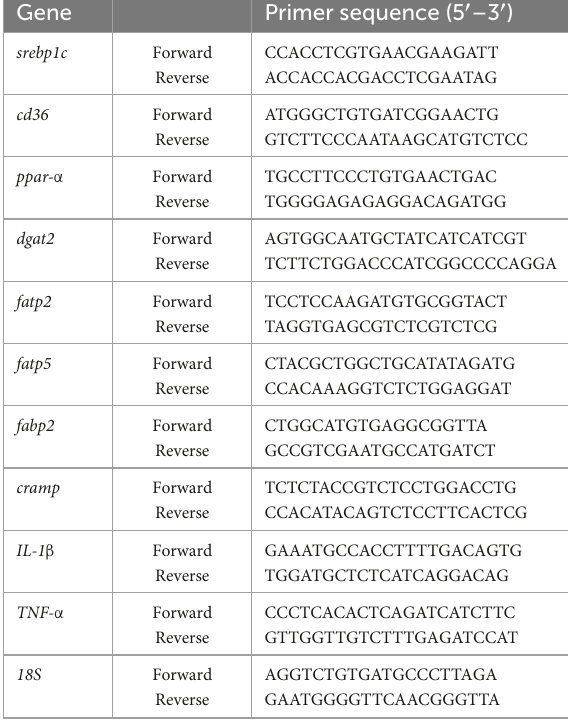
TABLE 1 Primer sequence for qRT-PCR. Gene Primer sequence (5 (cid:48) –3 (cid:48)